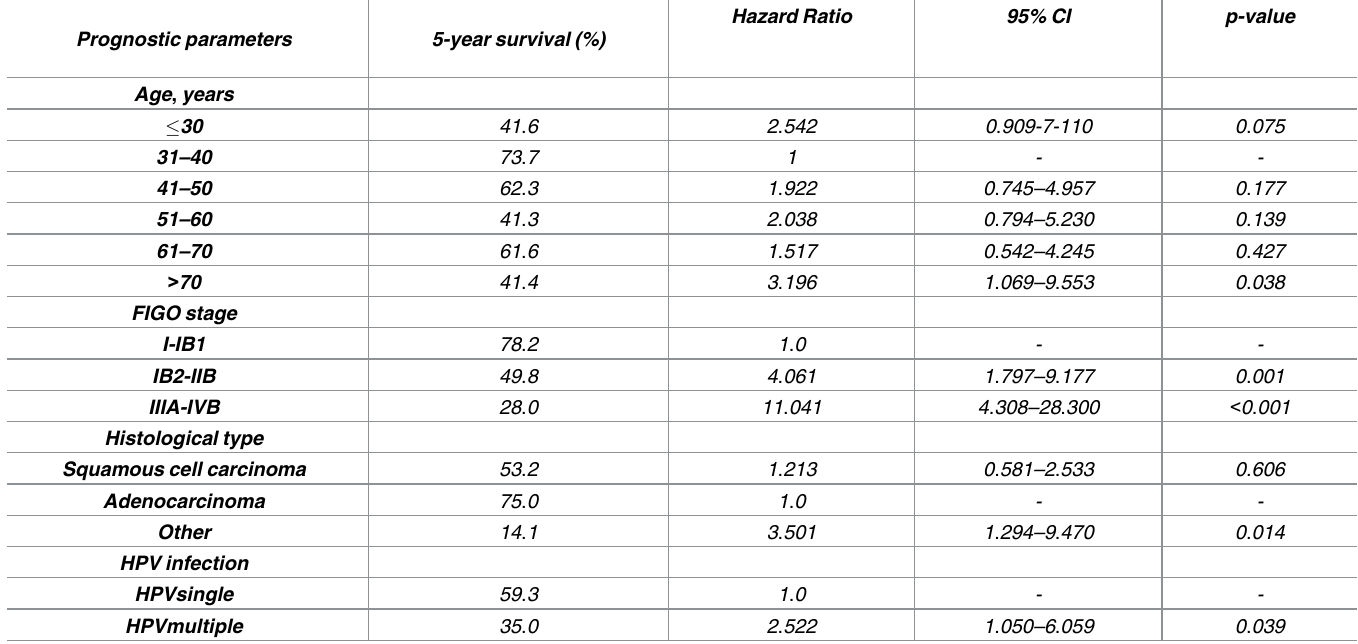
Table 4. Multivariate predictors of overall survival according to Cox proportional hazard model.